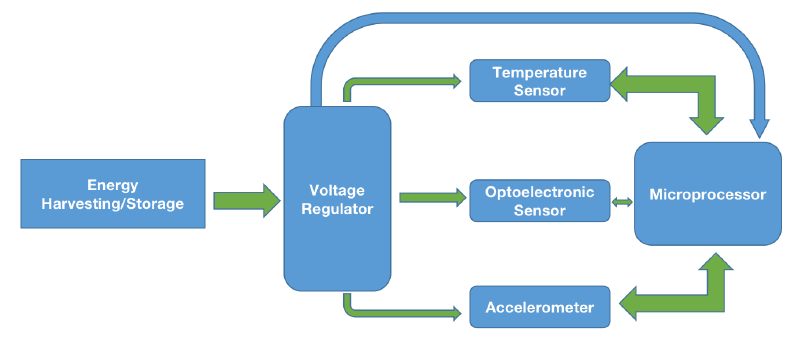
Figure 2. Abnormality detection with wireless multivariable intelligent